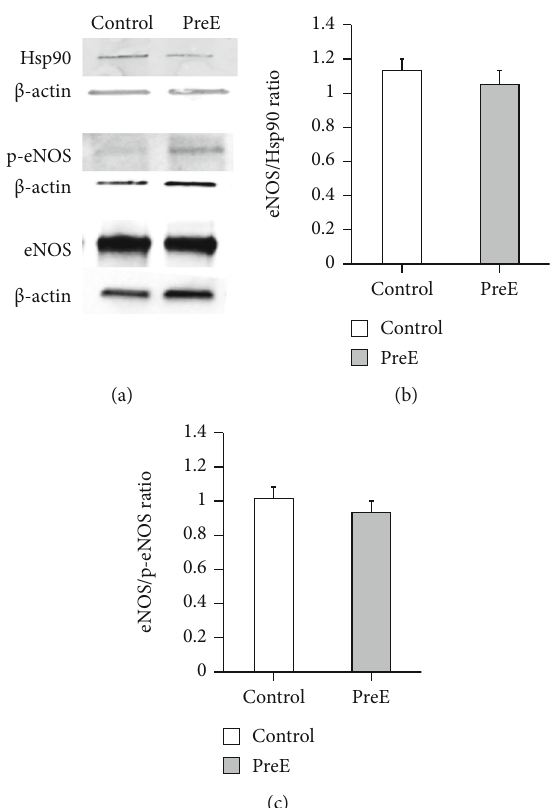
Figure 3: (a) eNOS, HSP90, and phospho-eNOS expression levels are not signi fi cantly changed in late onset pre-E. (b) Ratios of eNOS to phospho-eNOS and (c) eNOS to Hsp90 are not changed in late onset pre-E ( p ≤ 0 : 05 , n = 4 ).